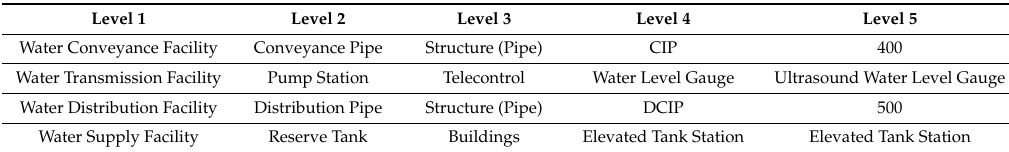
Table 8. An example of inventory construction.